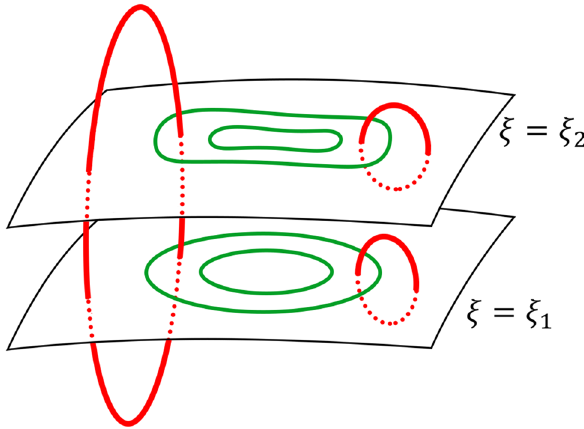
Figure 1. Poloidal (red) and toroidal (green) field. Each field line of the toroidal field lies in a constant- ξ surface, which is referred to as the toroidal field surface of the poloidal-toroidal representation. Field lines of the poloidal field thread a stack of isosurfaces of ξ . In a standard PT representation, the curl of a toroidal field is a poloidal field and the curl of a poloidal field should be a toroidal